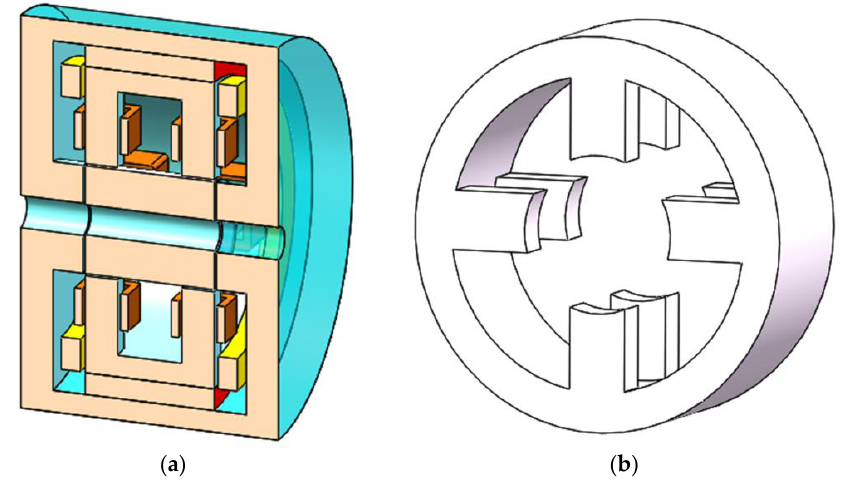
Figure 1. Configuration and the exploded view of the proposed 5-DOF HMB.